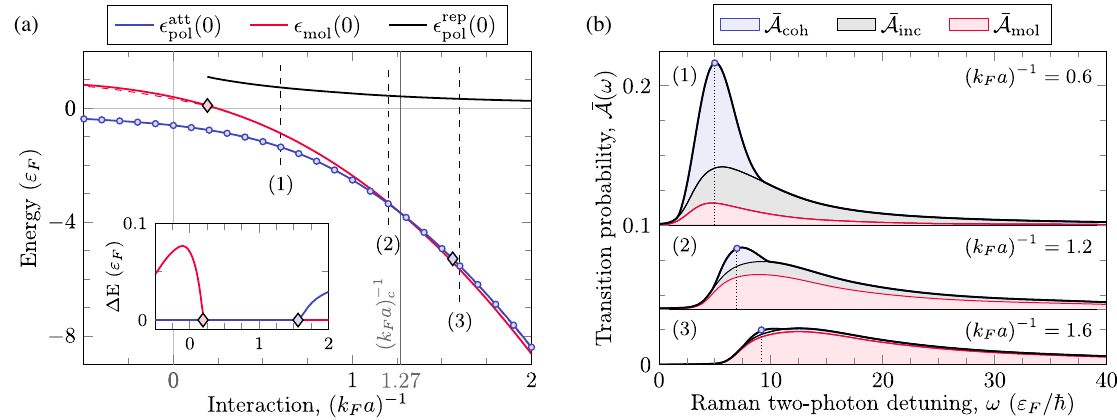
FIG. 3. Theoretical Raman spectra and quasiparticle energies. (a) Quasiparticle energies of different polaron and molecule states. The solid lines display the energy of the molecule (red) and the attractive (blue) and the repulsive (black) polaron at zero momentum as a function of the interaction strength, calculated from the variational states in Eqs. (2) and (3). The crossing of the polaron and molecule energies at ð k F a Þ − 1 c ≈ 1 . 27 results in a first-order transition from a polaronic to a molecular ground state. The blue circles show the peak position of the coherent part of the Raman spectrum. The comparison with the solid blue line makes it evident that the zero-momentum polaron energy can reliably be extracted using this approach. For the excited polaron and molecular states, the energy minimum does not always appear at zero momentum. We show the corresponding lowest energies of the attractive polaron and the molecule at finite momentum as dashed lines. Since the energies are almost degenerate, we indicate the interaction strengths at which the energy minimum switches to finite momentum by a diamond symbol. The inset shows the difference between the zero-momentum energy and the minimal energy for both polaron (blue) and molecule (red) branches. (b) Many-body Raman spectra of the imbalanced Fermi gas for three interaction strengths, calculated from an occupation average for fixed impurity concentration N I ¼ 0 . 15 N and temperature T ¼ 0 . 2 T F . The blue-, red-, and gray-shaded regions represent the coherent and incoherent polaronic contributions from Eq. (2) as well as the molecular contributions from Eq. (3), respectively. The coherent part yields an almost symmetric line shape that is peaked at the polaron energy shifted by the constant Raman two-photon recoil energy (vertical dotted line), while the incoherent and molecular parts lead to an asymmetric continuum. For clarity, the second and third graphs from the bottom are shifted by 0.04 and 0.1,